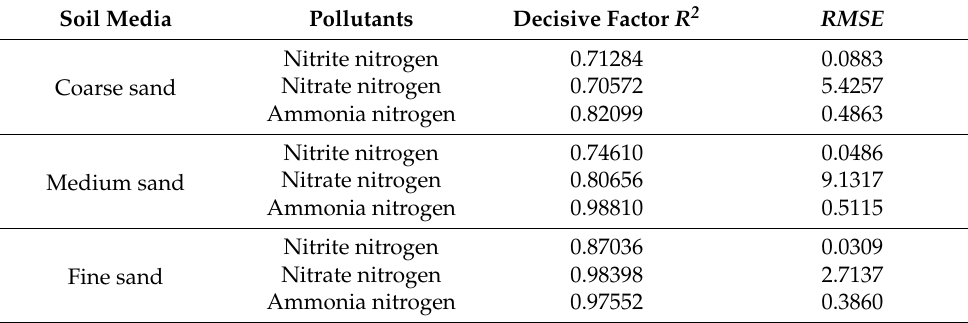
( c ) Figure 5. The process of nitrogen change in medium sand (( a ) nitrate nitrogen; ( b ) nitrite nitrogen; ( c ) ammonium nitrogen).